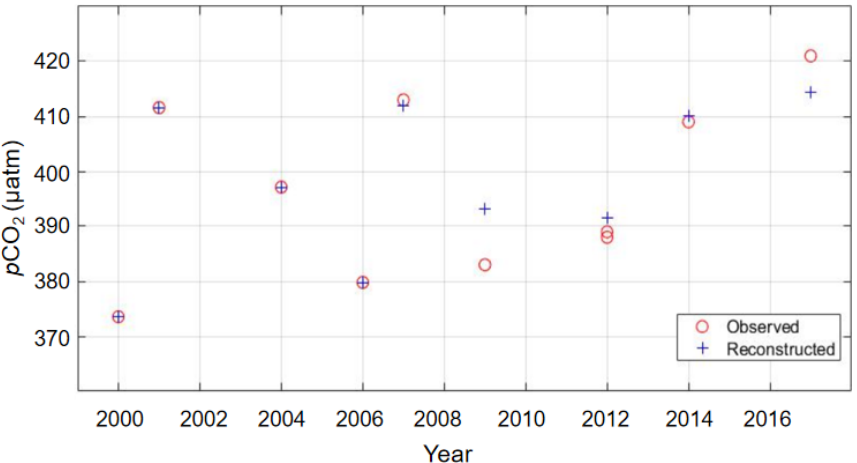
Figure 10. The comparison between the summer sea surface p CO 2 calculated from the observations and those from our reconstruction at Station SEATS (18 ◦ N, 116 ◦ E). The p CO 2 data calculated from the observations in the years of 2000, 2001, 2004, and 2006 are from Lui et al.